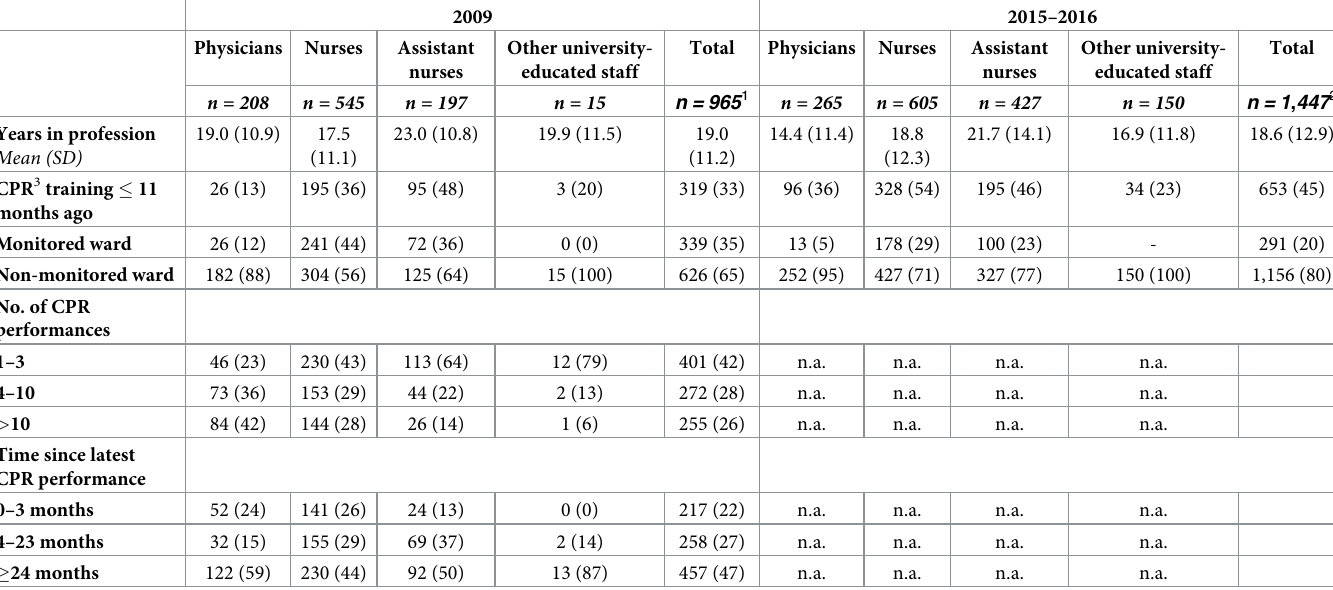
Table 1. Occupation, CPR training, previous CPR experience and workplace.